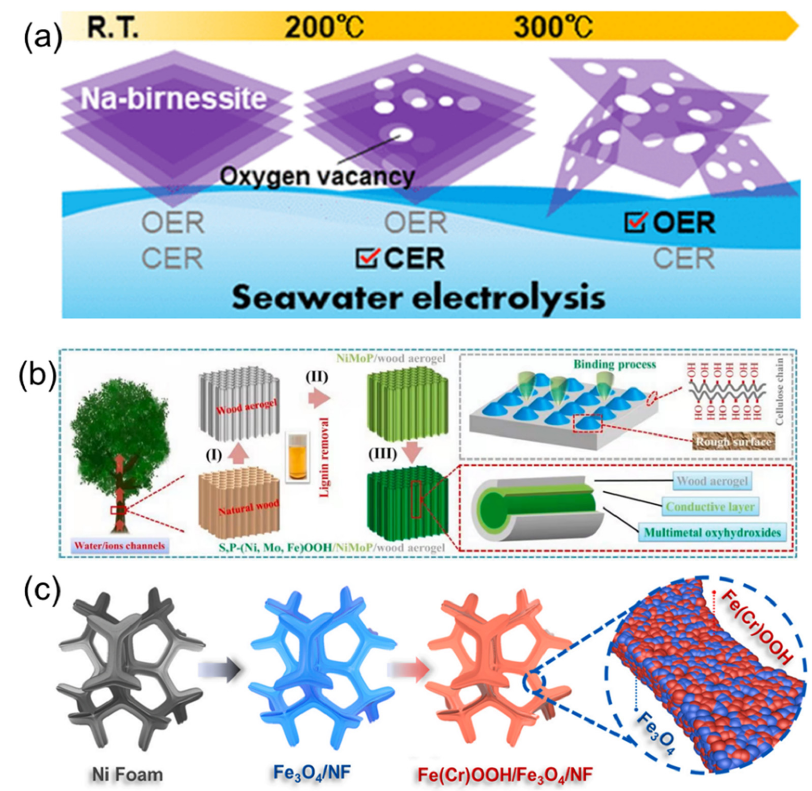
Figure 7. ( a ) The preparation and modulation of Na|MnO 2 followed by heat treatment [41]; ( b ) preparation procedure of the S,P-(Ni,Mo,Fe)OOH/NiMoP/wood [43]; ( c ) preparation of the Fe(Cr)OOH/Fe 3 O 4 /NF [44].